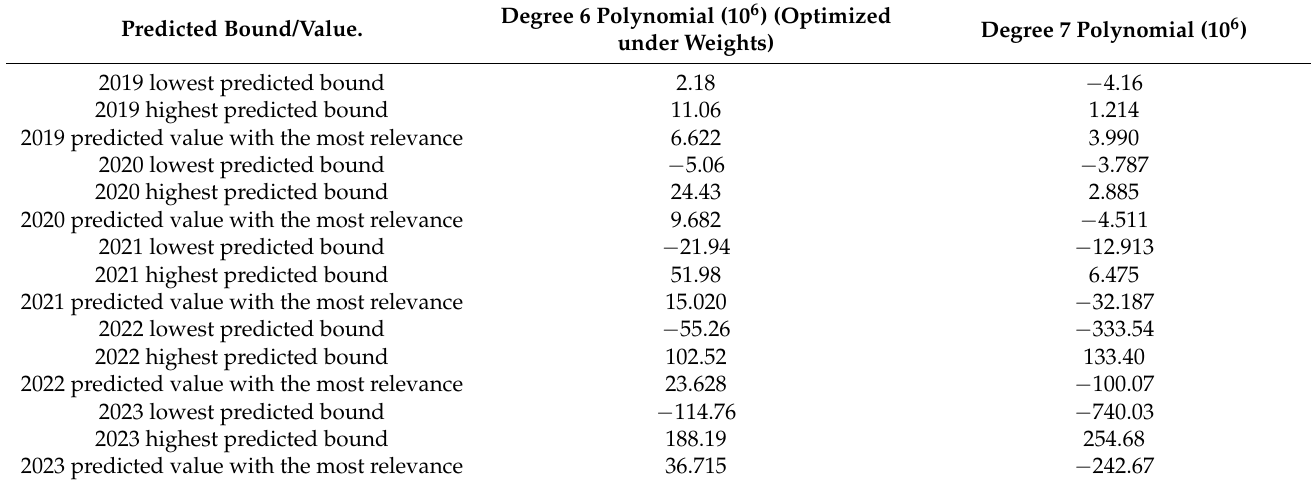
Table 2. Prediction for the degree 6 and the degree 7 polynomial